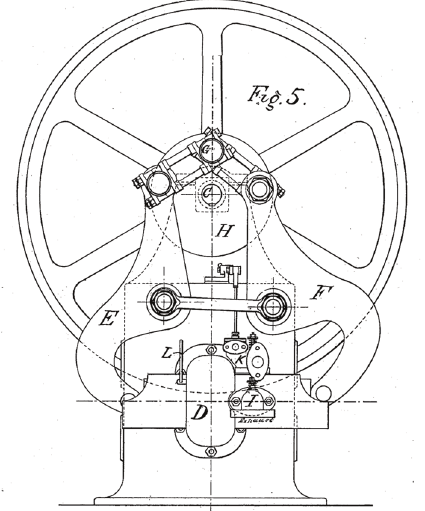
Fig. 1. Patent drawing of the Atkinson "Differential Engine", 1882